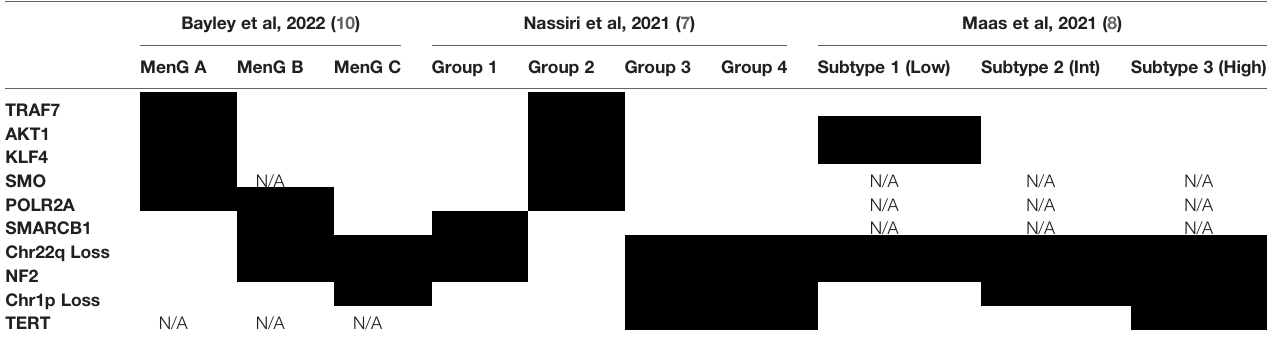
TABLE 1 | A comparative representation of studies describing molecular reclassi fi cation of meningiomas. Bayley et al, 2022